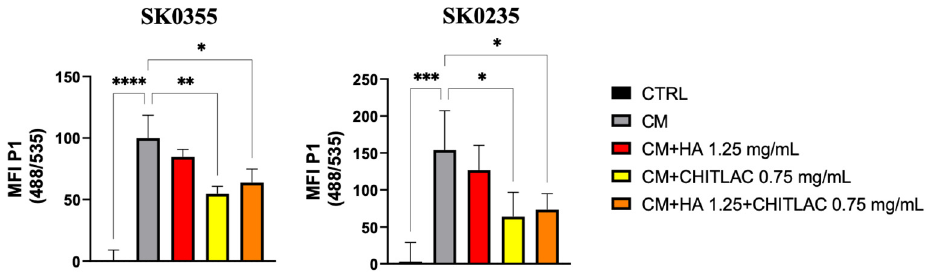
Figure 6. Reactive oxygen species (ROS) generation in human fibroblast cultures treated with U937 CM in the presence or absence of HA, CTL alone or in combination. Primary human fibroblasts SK0355 (from skin of a 30-year-old woman) and SK0235 (from skin of a 54-year-old woman) were exposed to U937 CM for 24 h before being treated for 4 h with 1.25 mg/mL HA, 0.75 mg/mL CTL, or a combination of the two. The intracellular ROS production of cells was then assessed using the 2’,7’-dichlorodihydrofluorescein diacetate probe and flow cytometry analysis, with at least 10,000 events collected. ROS production is measured as a percentage of the fluorescence intensity of U937 CM-treated cells. The one-way ANOVA test with multiple comparisons was used to determine statistical differences (Fisher LSD). The proportion of fluorescence seen in at least two independent trials is reported as mean ± SE, considering the control equal to 0. * p < 0.05, ** p < 0.01, *** p < 0.001 and **** p < 0.0001 vs. respective CM-treated control.